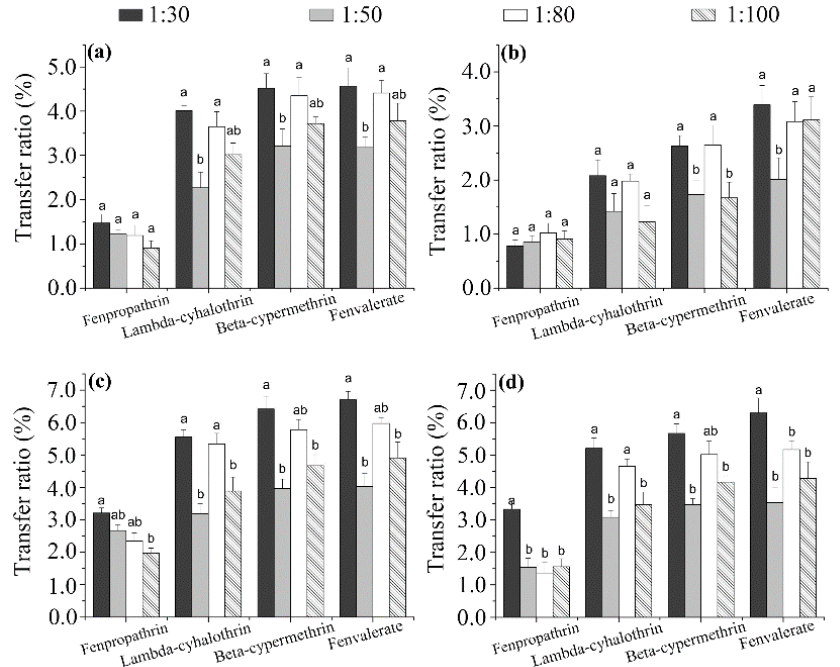
Figure 4. Effect of tea/water ratio on the transfer ratios of the four pyrethroid residues from wolfberry ( a ); licorice ( b ); honeysuckle ( c ); and chrysanthemum ( d ) tea to infusions. Different minor case letters (a, b) at the top of the columns mean significant differences of transfer ratio at a p value of 0.05.